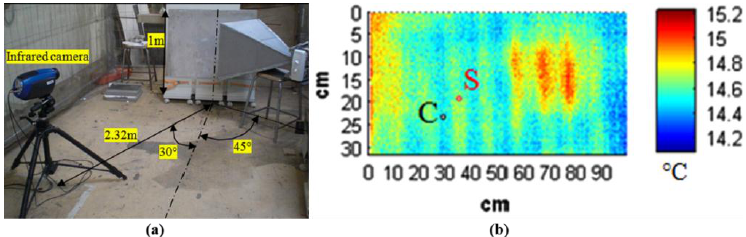
Figure 7. Photograph of microwave thermography measurement setup ( a ) and temperature profile for corroded steel bar ( b ) [65]. Reprinted/reproduced with permission from Elsevier.